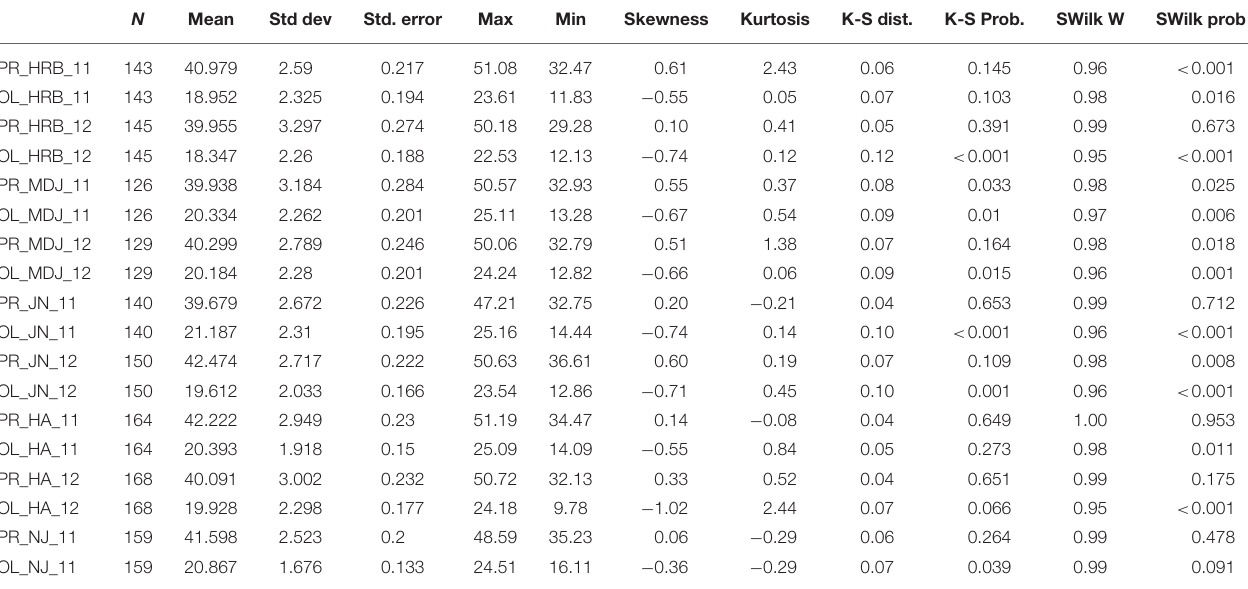
TABLE 5 | The basic statistics of protein and oil contents of cultivars grown at different locations in 2011 or